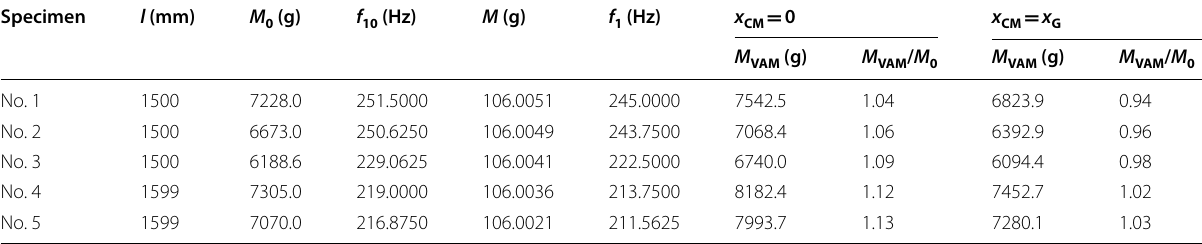
l : specimen length; M 0 : measured specimen mass; f 10 : resonance frequency of the first mode without the concentrated mass; M : concentrated mass; f 1 : resonance frequency with the concentrated mass of the first mode; x CM : position of the concentrated mass; x G : center of gravity of the concentrated mass (15 mm from the end);